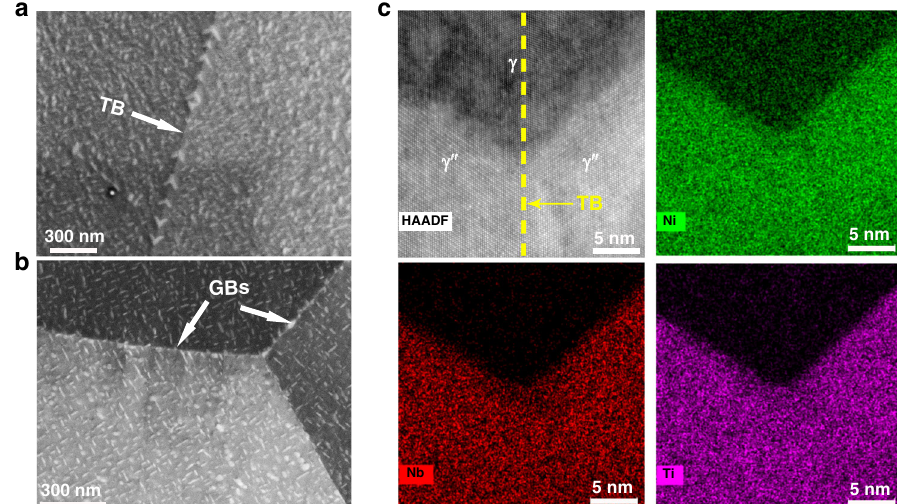
Fig. 1 Morphology of γ ″ precipitates at twin boundaries (TBs) and near general grain boundaries (GBs), and element distribution across TBs. BSE images showing ( a ) V-shaped γ ″ along a twin boundary (TB) and ( b ) γ ″ near GBs at a triple junction; c HAADF-STEM image containing γ and γ ″ across a TB and the corresponding EDX elemental maps (Ni, Nb,